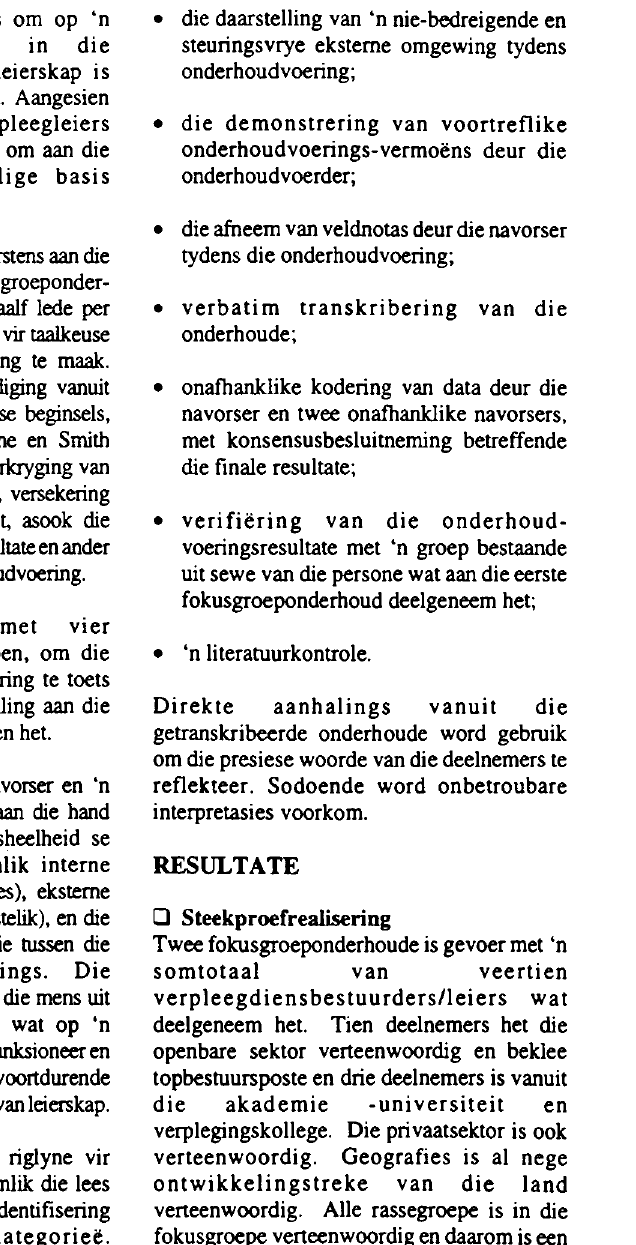
fokusgroepe veriecnwoordig en daarom is een van die onderhoude in Engels